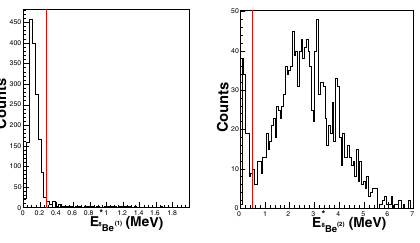
Figure 2. Left panel: minimum relative energy of couples of α -particles. Right panel: relative energy of the complementary couple.